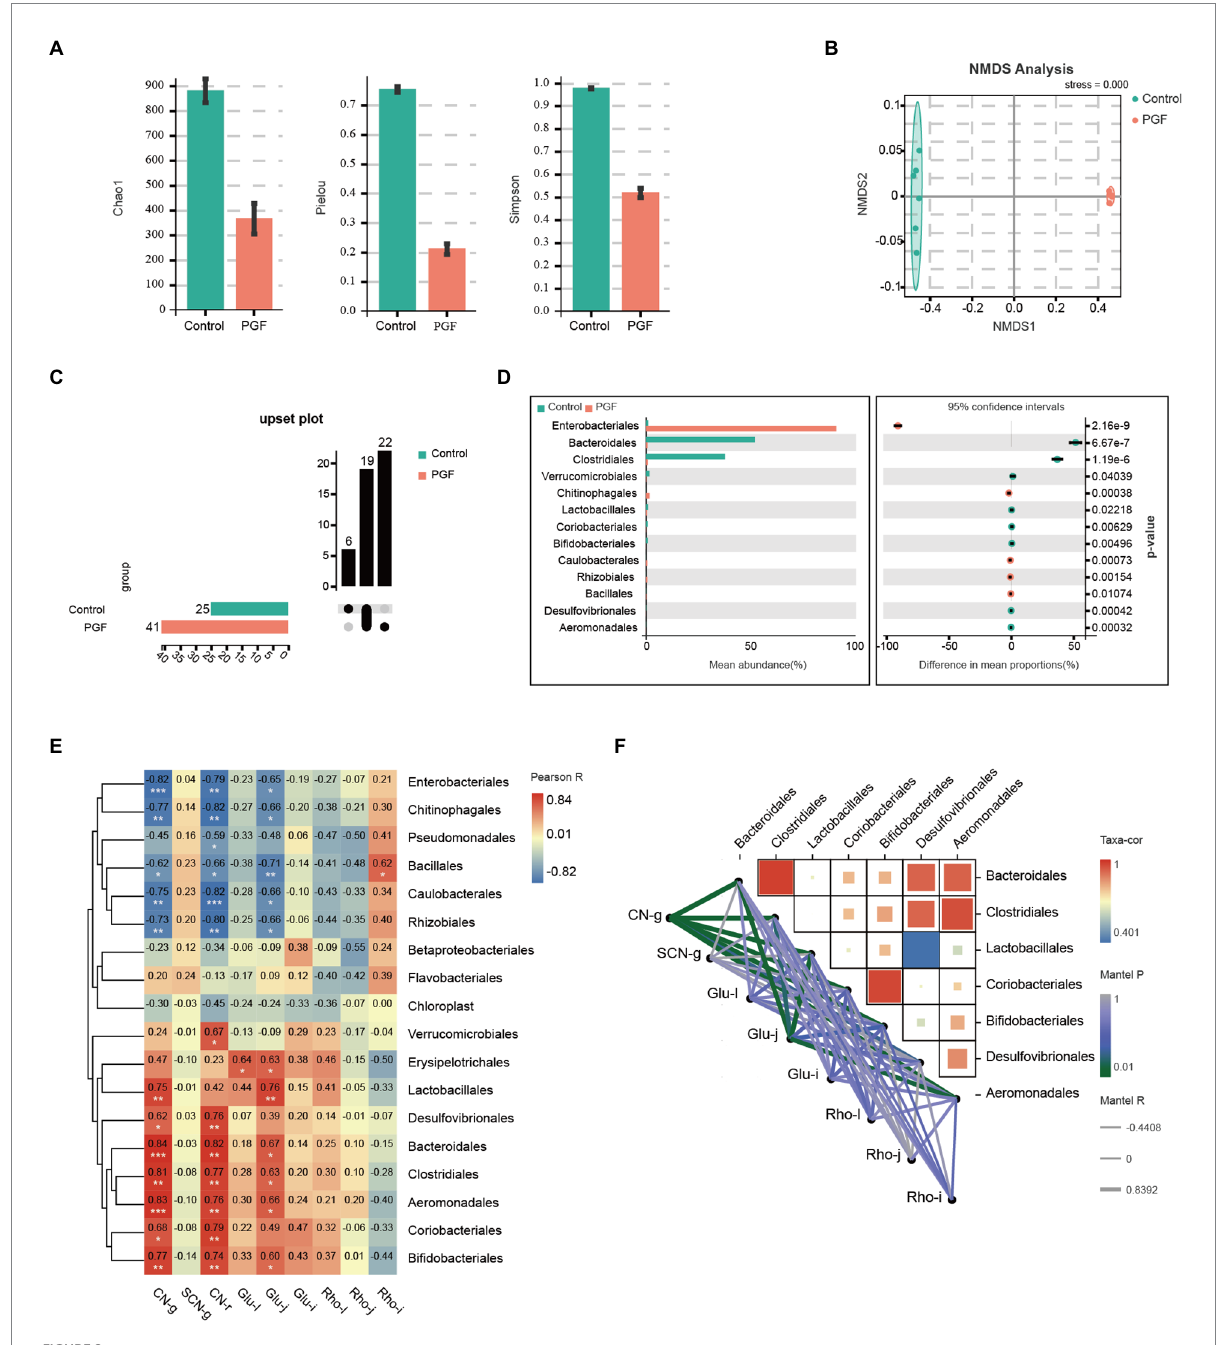
FIGURE 8 Intestinal microbiota composition difference of the control and PGF groups ( n = 6). (A) Chao1, Pielou, and Simpson indexes ( p < 0.01); (B) Non-metric multidimensional scaling (NMDS) plot based on Bray-Curtis distances comparing microbiota composition between the control and PGF group, stress = 0.000, p < 0.01; (C) Upset plot based on bacterial orders; (D) Different taxa at order level, p < 0.05; (E) Correlation heatmap between the detected indexes and bacterial orders based on Pearson correlation coefficient, * p < 0.05, ** p < 0.01, and *** p < 0.001; (F) Correlation heatmap between bacterial orders and bacterial orders determined based on correlation coefficient and p value, and correlation network between bacterial orders and detected indexes based on Pearson correlation coefficient and p value. CN-g and SCN-g: concentrations of CN and SCN in the incubation experiment; glu-l, glu-j, and glu-i: β -glucosidase activity of liver, jejunum, and ileum; rho-l, rho-j, and rho-i: rhodanese expression of liver, jejunum, and ileum; Taxa-cor: correlation coefficient between bacterial orders based on Pearson correlation analysis; Mantel P: p value of Mantel test between taxa and the metabolic indicators based on Pearson correlation analysis; Mantel R: correlation coefficient of Mantel test between taxa and the metabolic indicators based on Pearson correlation